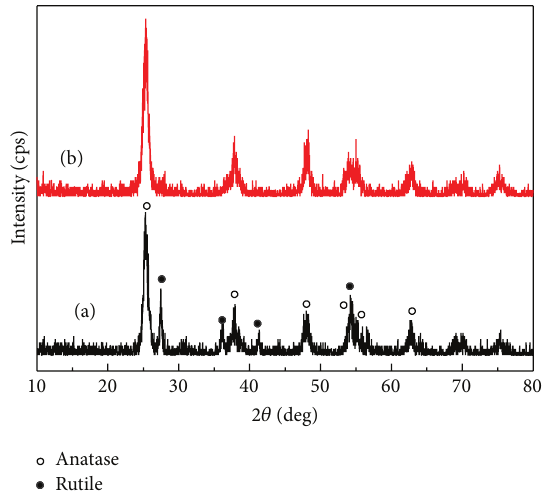
Figure 2: XRD patterns of TiO 2 prepared through calcining the TiO 2 /PS composite at different temperatures: (a) 450 ∘ C and (b) 500 ∘